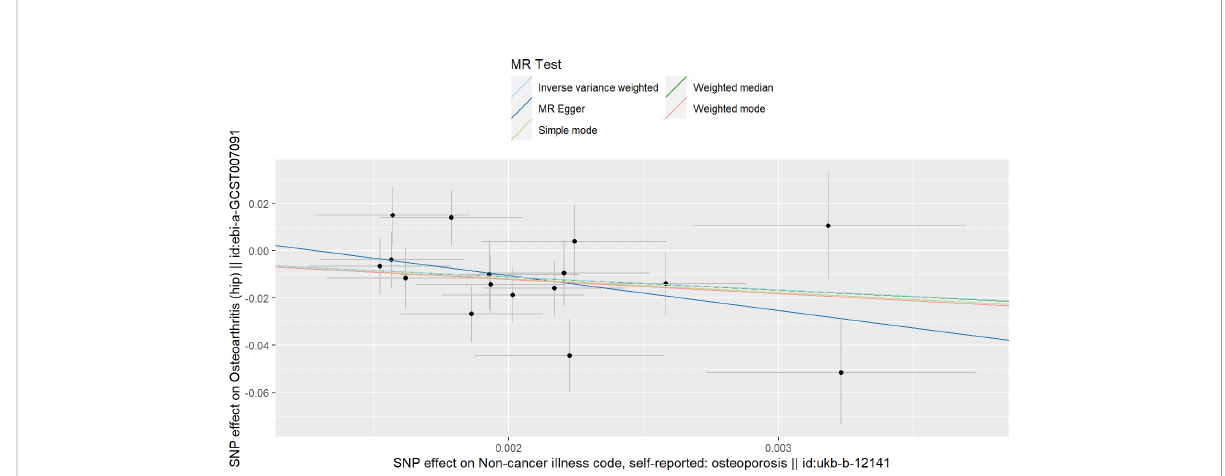
FIGURE 1 Scatterplots of the causal relationships between osteoporosis and total